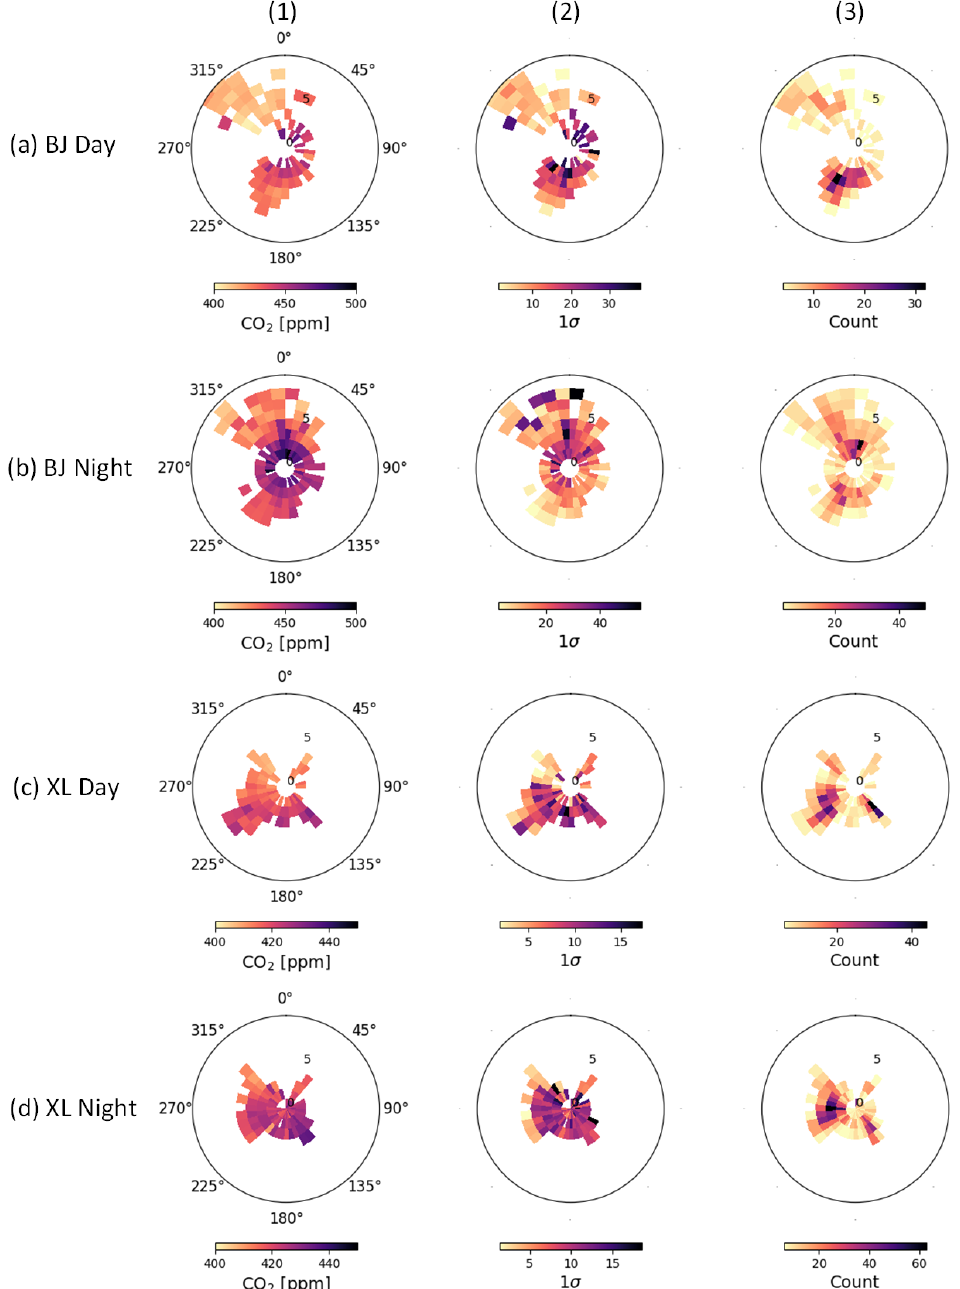
Figure 11. (1) Binned CO 2 mole fraction as a function of wind speed (ms − 1 ) and wind direction ( ◦ ) at BJ L1 (a, b) and XL (c, d) based on daytime (14:00–16:00LTC) and nighttime (22:00–01:00 LTC) data between October 2018 and September 2019. (2) Mean 1 σ standard deviation of the CO 2 mole fractions in each bin. (3) The CO 2 measurement counts in each